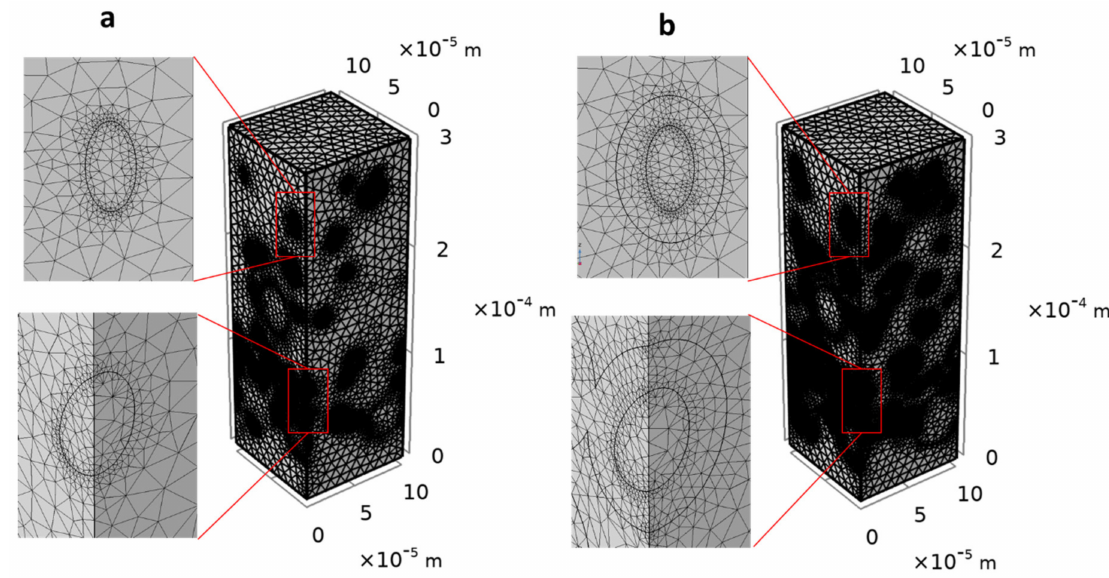
Figure 5. Tetrahedral mesh presentation of 3D composite structures corresponding to particles volume fraction of ϕ p = 11.4 % v / v (240 particles): ( a ) two–phase system and ( b ) three–phase